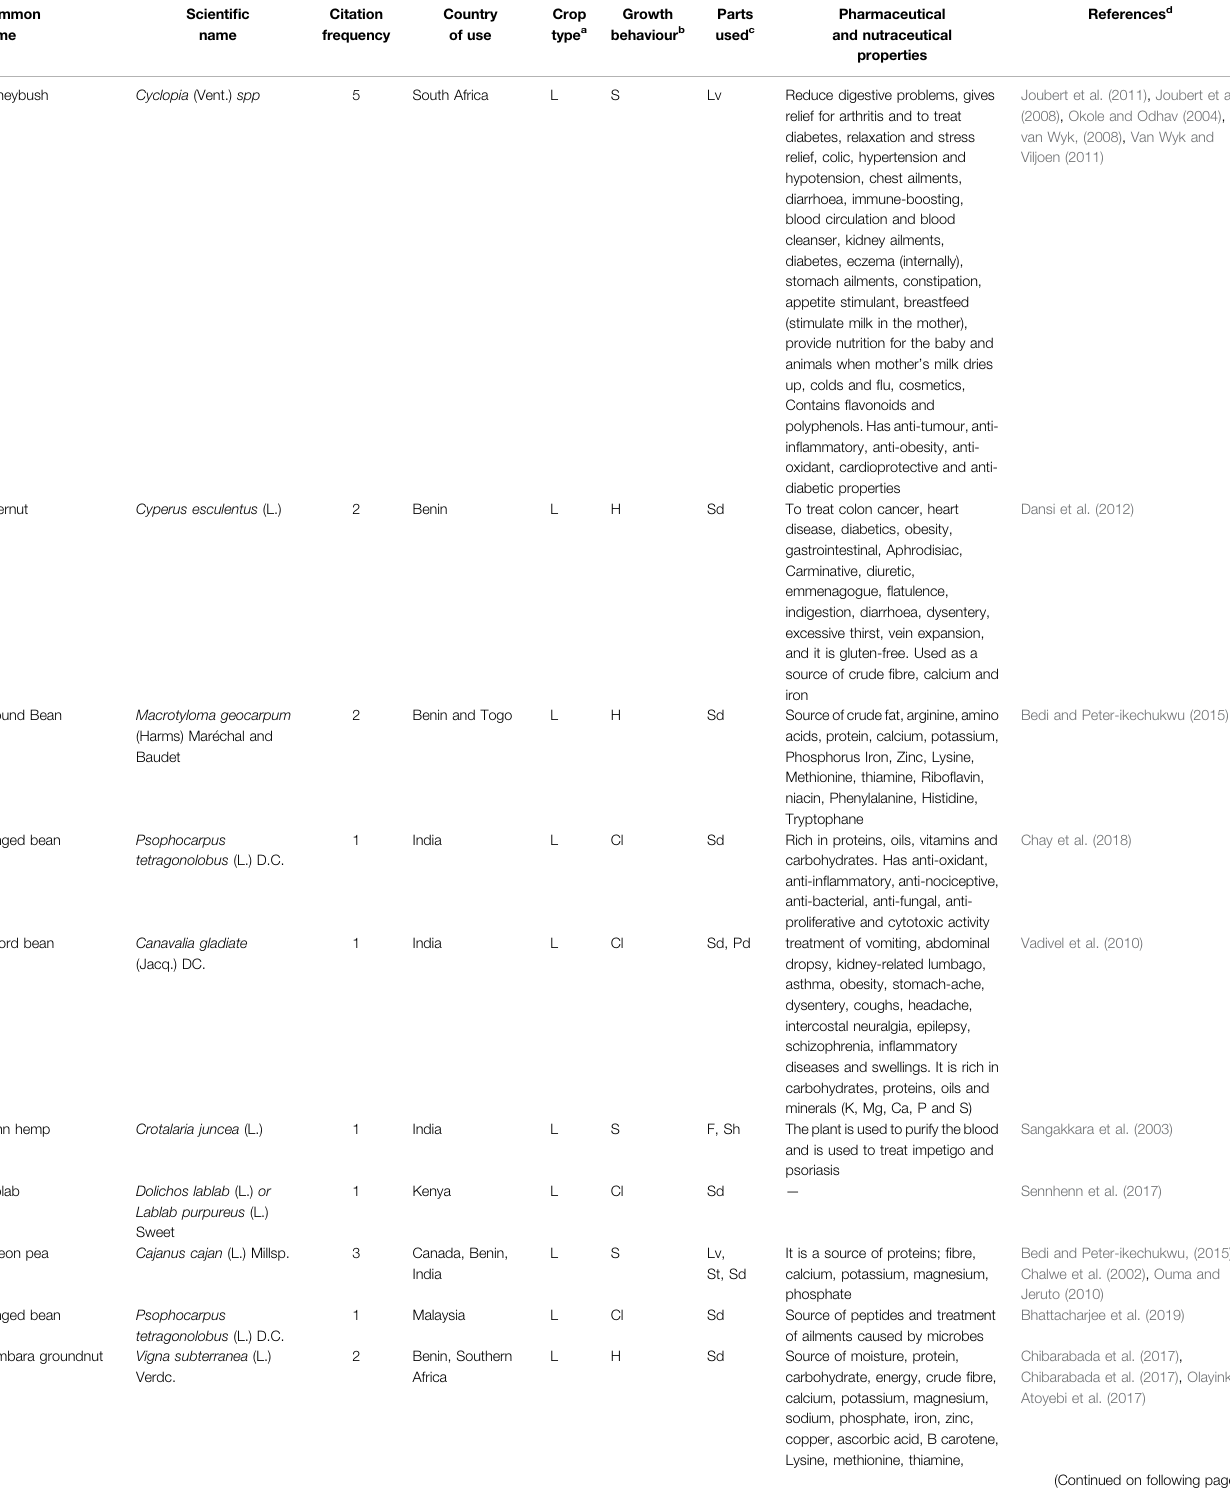
TABLE 1 | Results of neglected functional medicinal crop species from the systematic review. 1 Crop type -Legume (L), Herb (H), Cereal (C), Cucurbit (Cu), Root and tuber (RT),Tree(T),Shrub(S),Leafyvegetable(LV),Pseudocereal(P) 2 Growthbehaviour-Herb (H),Creeper (Cr),Climber(Cl),Tree(T),Shrub(S), 3 Plantpart — Root(R),Shoot (Sh), Seed (Sd), Stem (St), Flower (Fr), Pod (Pd), Leaves (Lv), Bark (B), Corm (Cm), Tuber